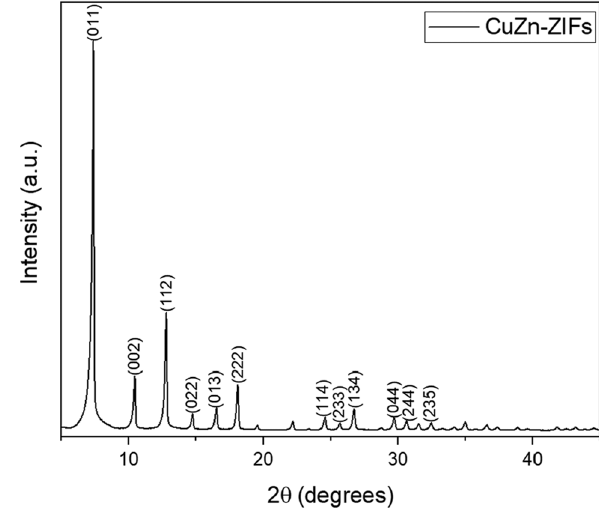
Figure A3: PXRD pattern of CuZn -